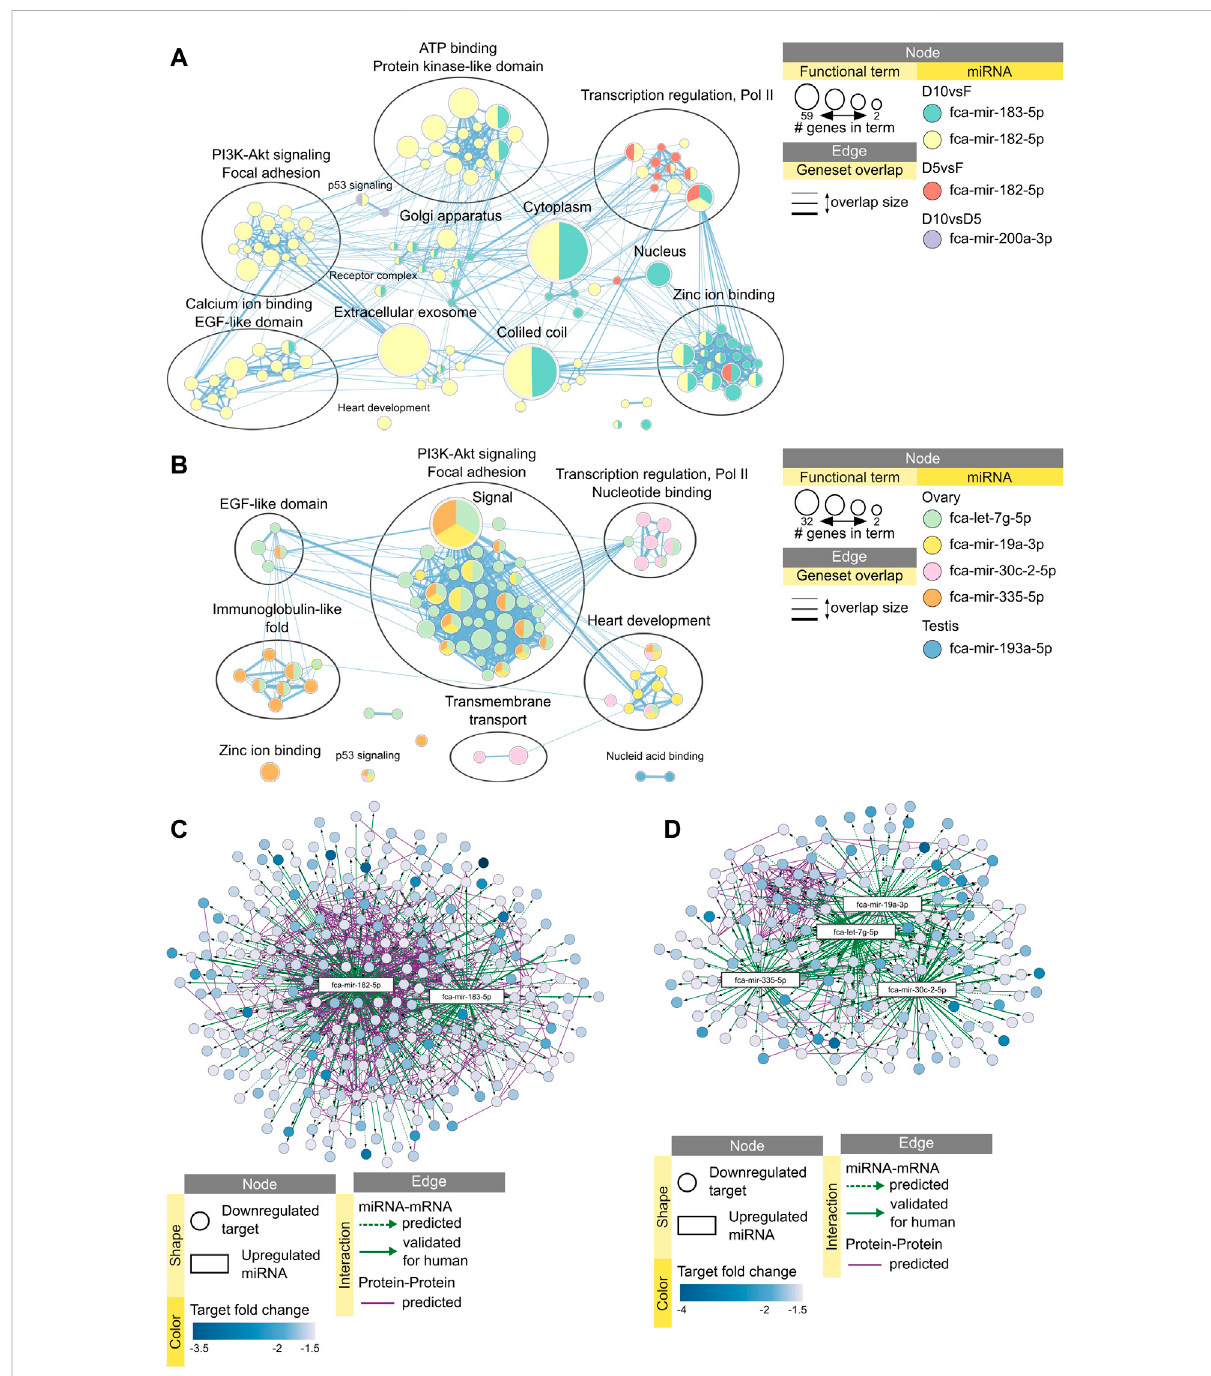
FIGURE 7 Impact of miRNAs on functional terms, pathway, and protein-protein interactions in response to preservation protocols. Enrichment map displays enriched gene-sets based on downregulated mRNA targets for each upregulated miRNA after (A) 5 or 10 min dehydration, and (B) vitri fi cation of ovarian or testicular tissues. Interactive networks including networks of each functional cluster with corresponding data tables are available in Supplementary Data Sheet S4. (C) miRNA-mRNA-mRNA network for upregulated miRNAs and downregulated mRNAs in response to 10 min dehydration. (D) miRNA-mRNA-mRNA network for upregulated miRNAs and downregulated mRNAs in response to vitri fi cation in ovarian tissue. Interactive networks with corresponding data tables are available in Supplementary Data Sheet